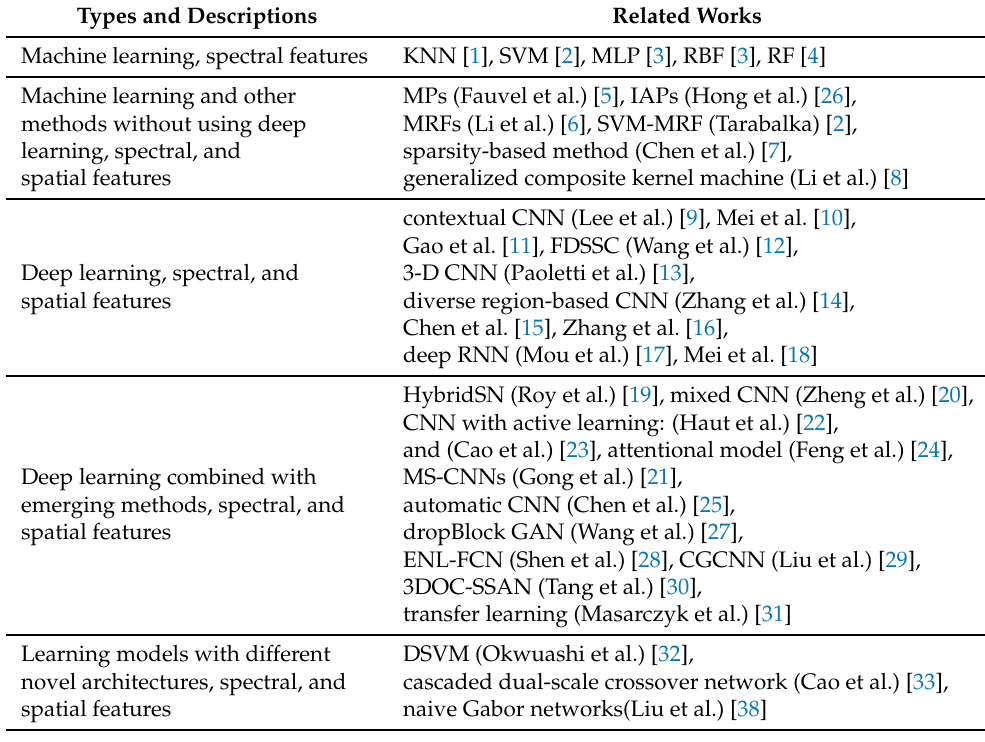
Table 1. Hyperspectral classification